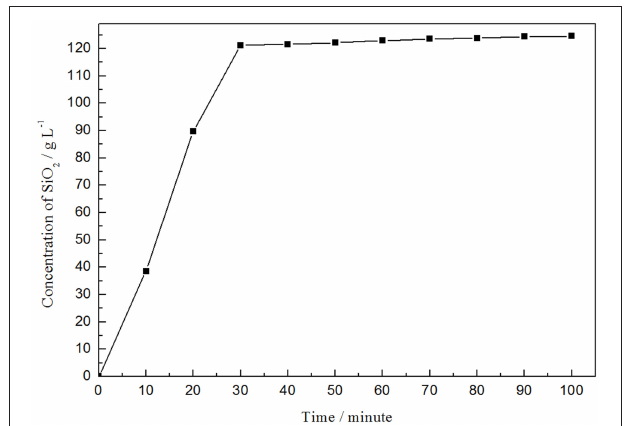
FIGURE 3 | Variation of silica concentration with reaction